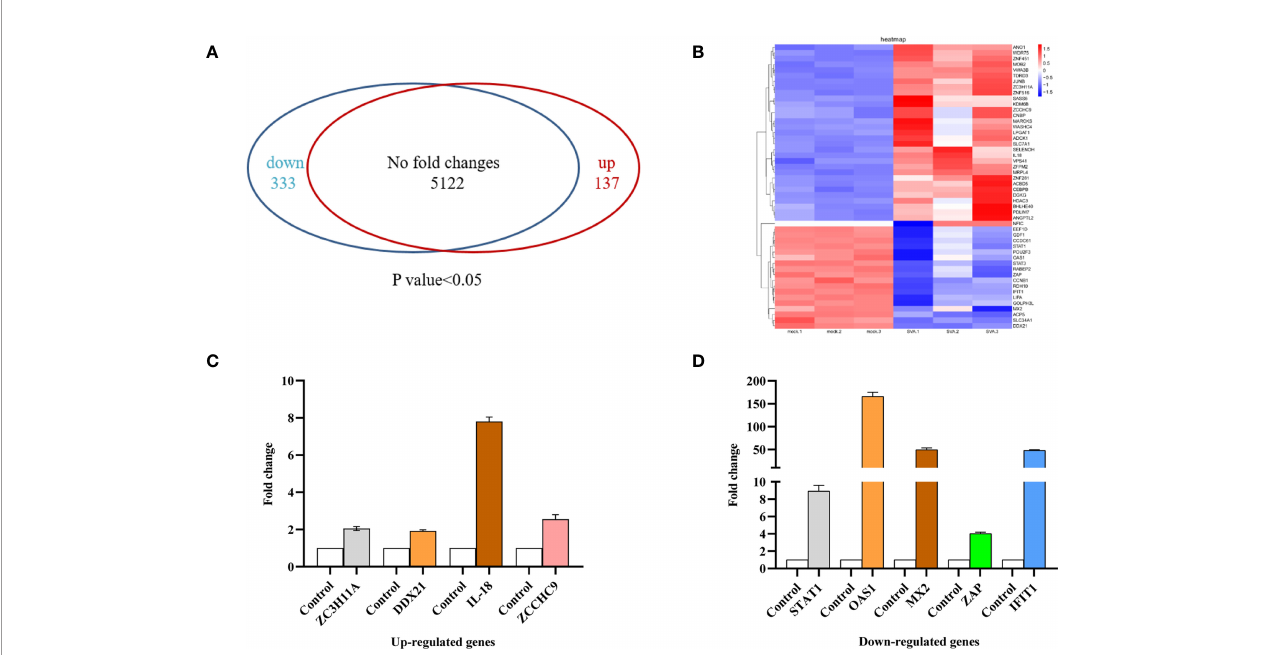
FIGURE 2 | Proteomic analysis of SVA-infected PK-15 cells. PK-15 cells were mock or SVA infected at a MOI of 0.5 and harvested at 48 hpi for proteomic analysis. (A) The Venn diagram represents the number of genes upregulated and downregulated in PK-15 cells in response to SVA infection. (B) Cluster analysis of the upregulated and downregulated genes with the greatest fold change values. Red indicates increased (infected/mock) gene expression, and blue indicates decreased expression. (C, D) Validation of TMT data by qRT-PCR analyses. ZC3H11A, DDX21, IL-18, and ZCCHC9 mRNA levels were upregulated, and STAT1, OAS1, MX2, ZAP, and IFIT1 mRNA levels were downregulated. Values are presented as means ± SD from three independent